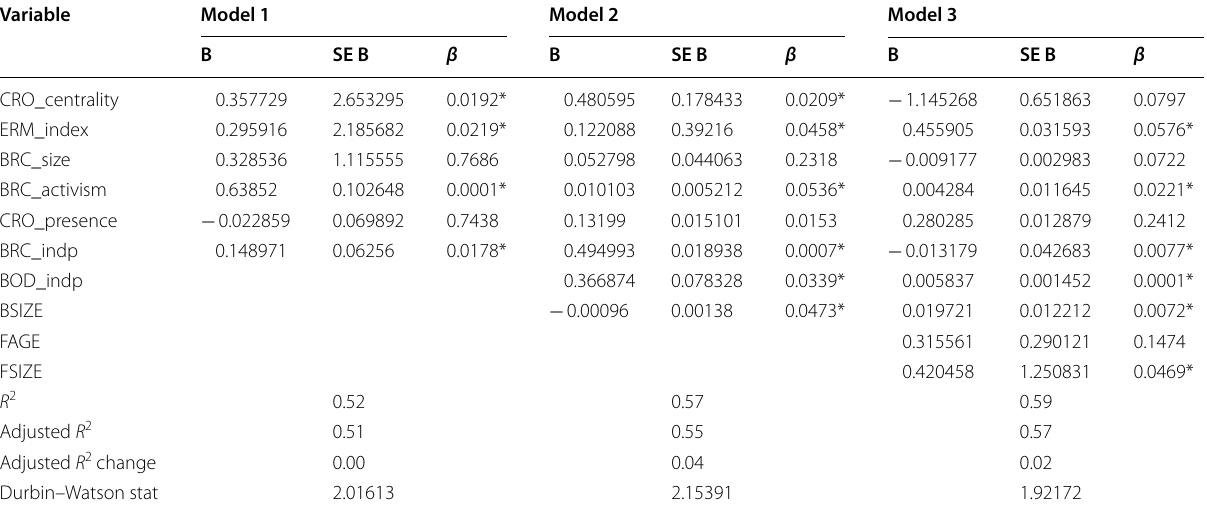
Table 5 Hierarchical regression